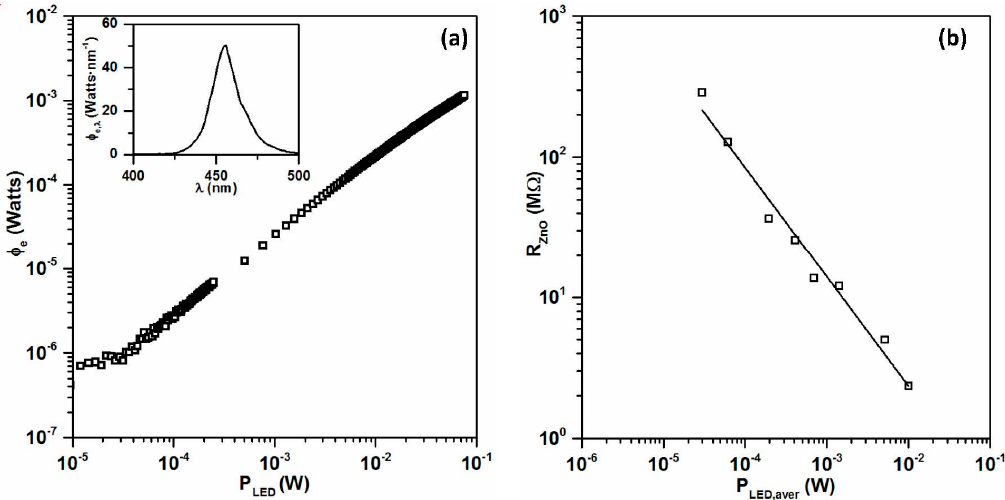
Figure 2. (a) Emission characteristics of the LEDs (relationship between electrical power P LED and φ e power of the light emitted, and emission spectra); ( b ) Effect of the light emitted on the ZnO NW’s resistance (i.e., photoconductivity).